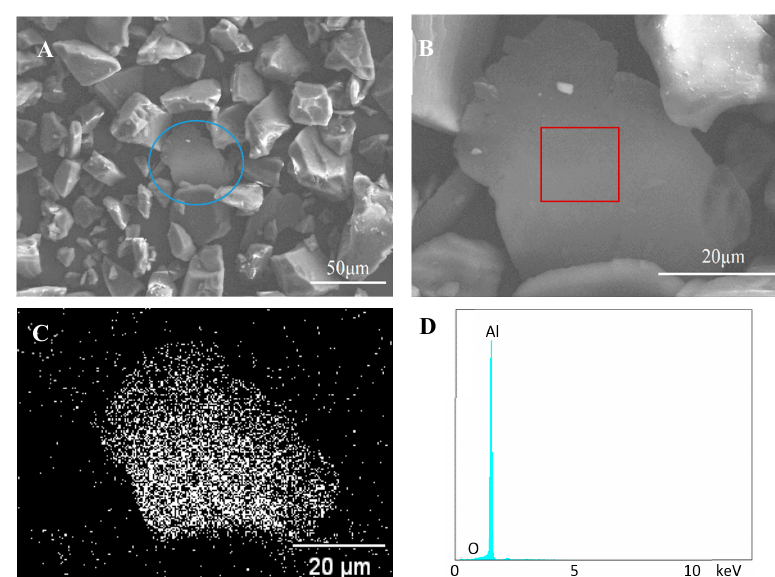
Figure 3. Scanning electron microscope (SEM) and energy-dispersive X-ray spectroscopy (EDS) images of control samples. ( A , B ) SEM images of non-bonded sample; ( C ) EDS scanning of aluminum element; ( D ) EDS spectrum of the rectangle area in ( B ). Table 1. Al content comparison of non-bonded powder ( − 30